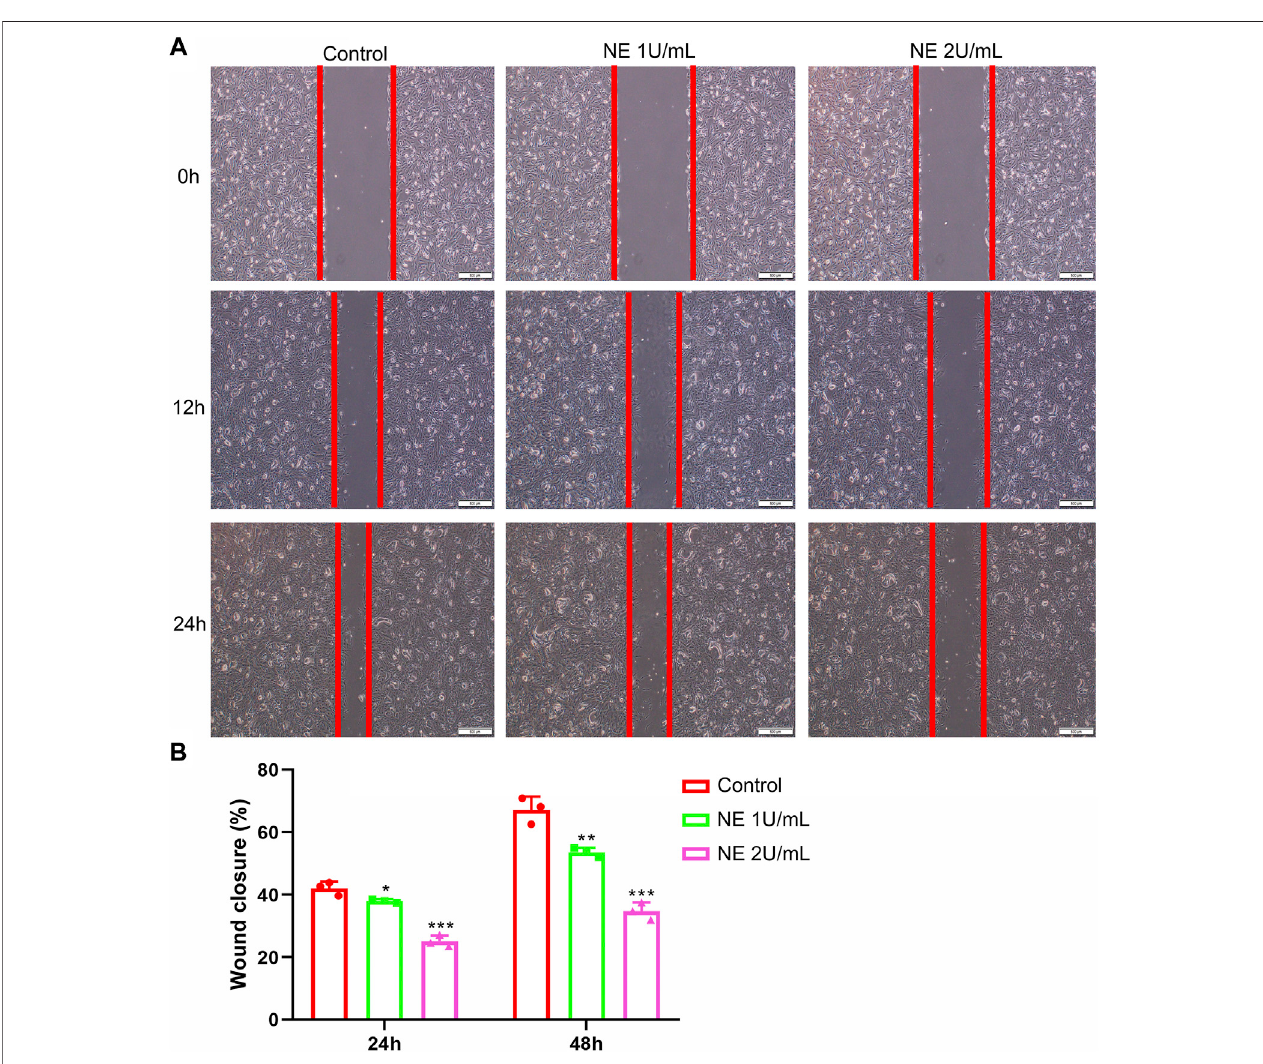
FIGURE6| Neutrophilelastaseinhibitsthemotilityofchondrocytes. (A,B) Migrationofchondrocyteswasevaluatedusingthe invitro wound-healingscratchassay. (A) Representative photomicrographs of chondrocytes. (B) For quantitative analysis, percentage of wound closure was determined. Data are mean ± SEM; n (cid:1) 3. * p < 0.05, ** p < 0.01, *** p <